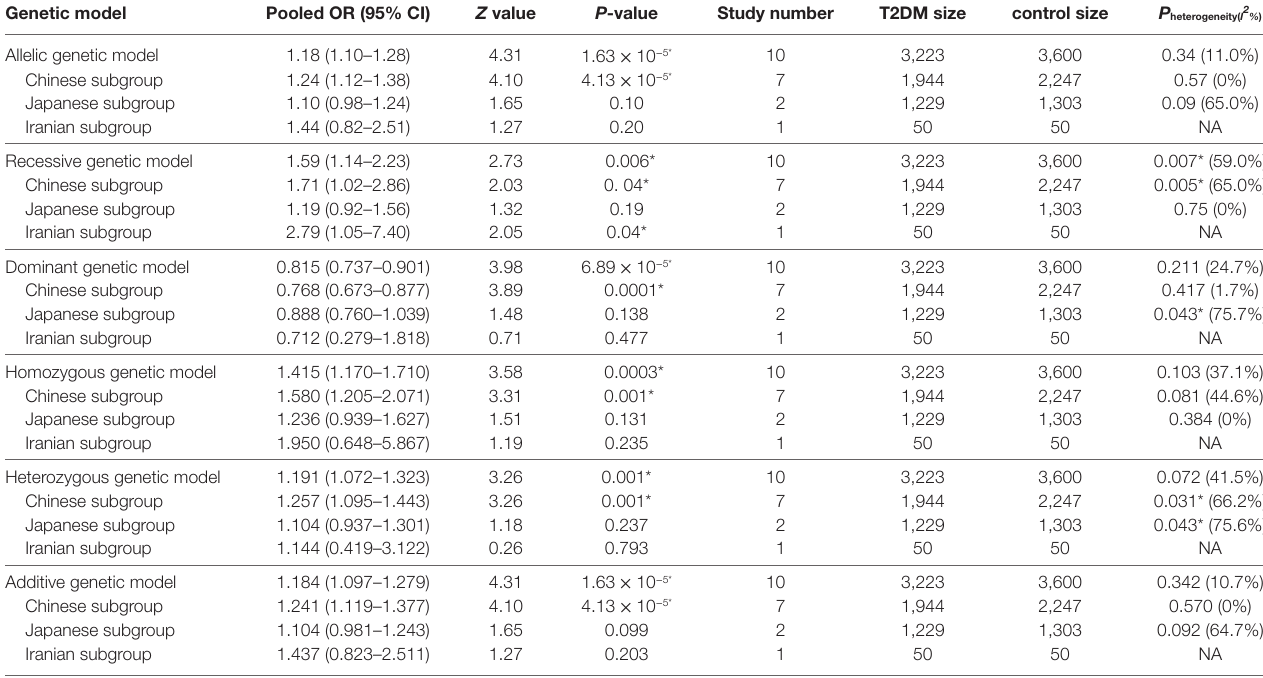
TaBle 2 | Summary of meta-analysis of association between small ubiquitin-like modifier 4 (SUMO4) gene M55V polymorphism and type 2 diabetes mellitus (T2DM). genetic model